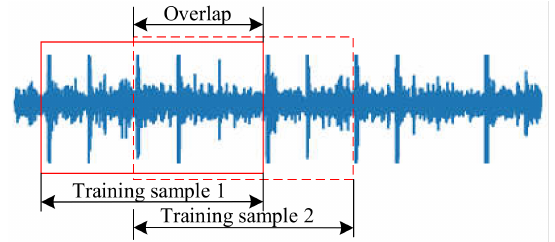
Figure 6. Schematic diagram of sample